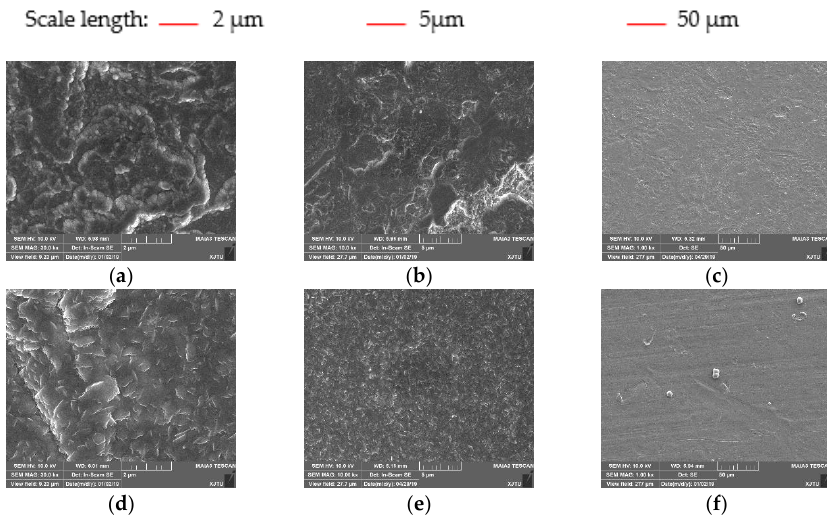
Figure 3. The SEM (Scanning electron microscope) micrographs of the Ti and Ti–Zr–V–Hf film coatings Figure 3. The SEM ( Scanning electron microscope ) micrographs of the Ti and Ti–Zr–V–Hf film coatings with cleaned OFHC substrates at different scales. Here, (a) , (b) and (c) are the SEM with cleaned OFHC substrates at di ff erent scales. Here, ( a – c ) are the SEM micrographs of Ti–Zr–V–Hf micrographs of Ti–Zr–V–Hf film coatings. (d) , (e) and (f) are the SEM micrographs of Ti film coatings. film coatings. ( d – f ) are the SEM micrographs of Ti film coatings.